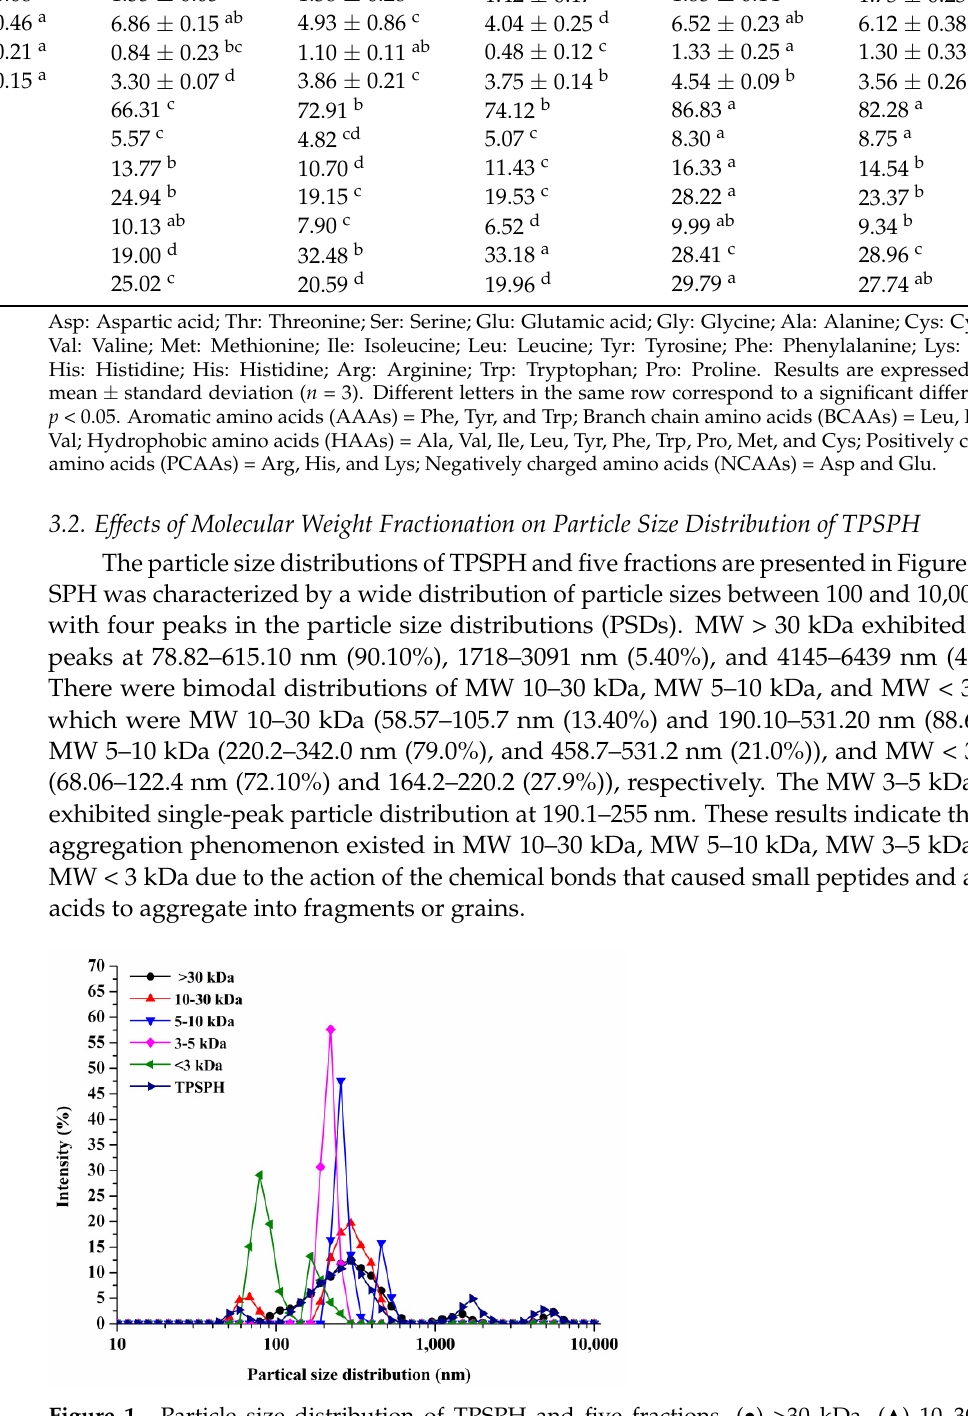
Figure 1. Particle size distribution of TPSPH and five fractions, ( ● ) >30 kDa, ( ▲ ) 10–30 kDa, ( ▼ ) 5– 10 kDa, ( ♦ ) 3–5 kDa, ( ◄ ) <3 kDa, and ( ► ) TPSPH.